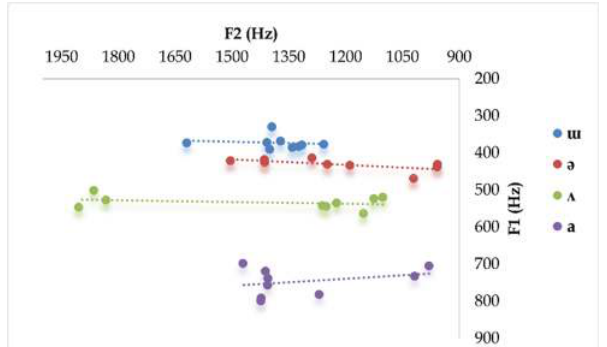
Figure 7. Scatter plot of mid vowel formant